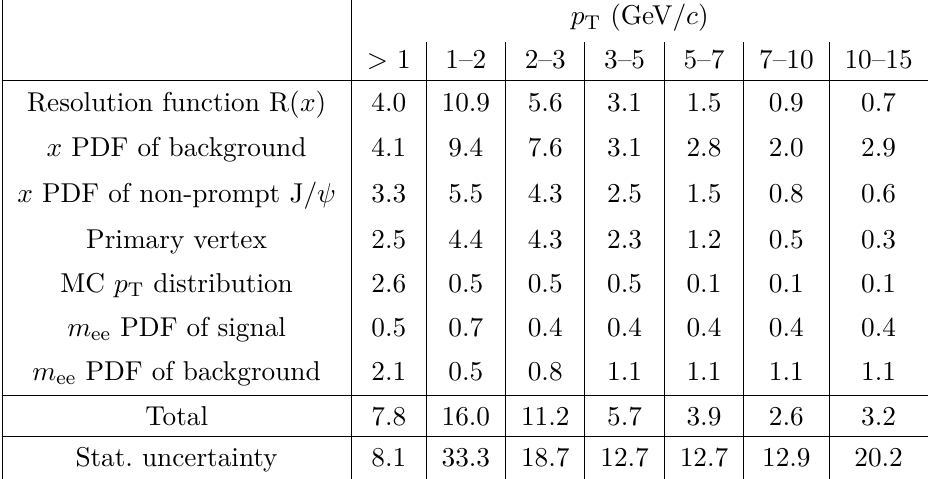
Table 1 . Systematic uncertainties of f B , expressed in %, for all p T intervals considered in the √ analysis performed at s = 13 TeV. In the last row the statistical uncertainties on f B are also reported.